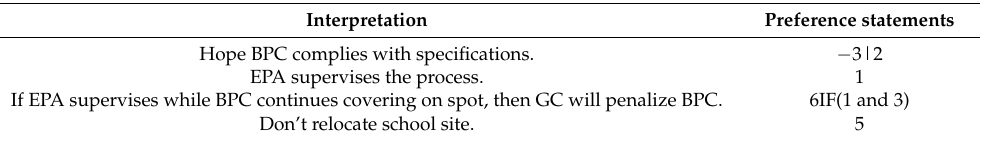
Table 6. Preference Statements of GC.